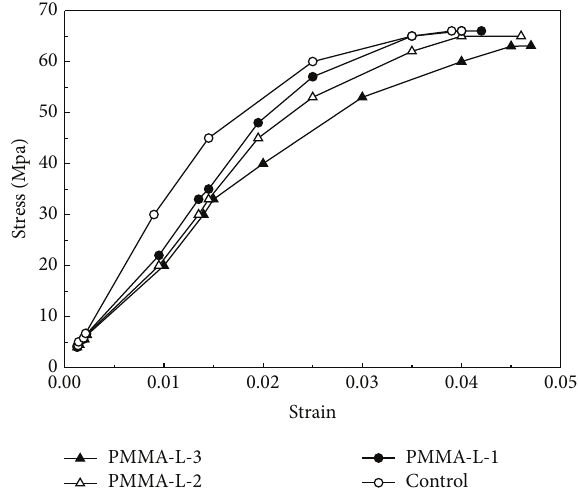
Figure 5: Stress-strain curve of composite samples.